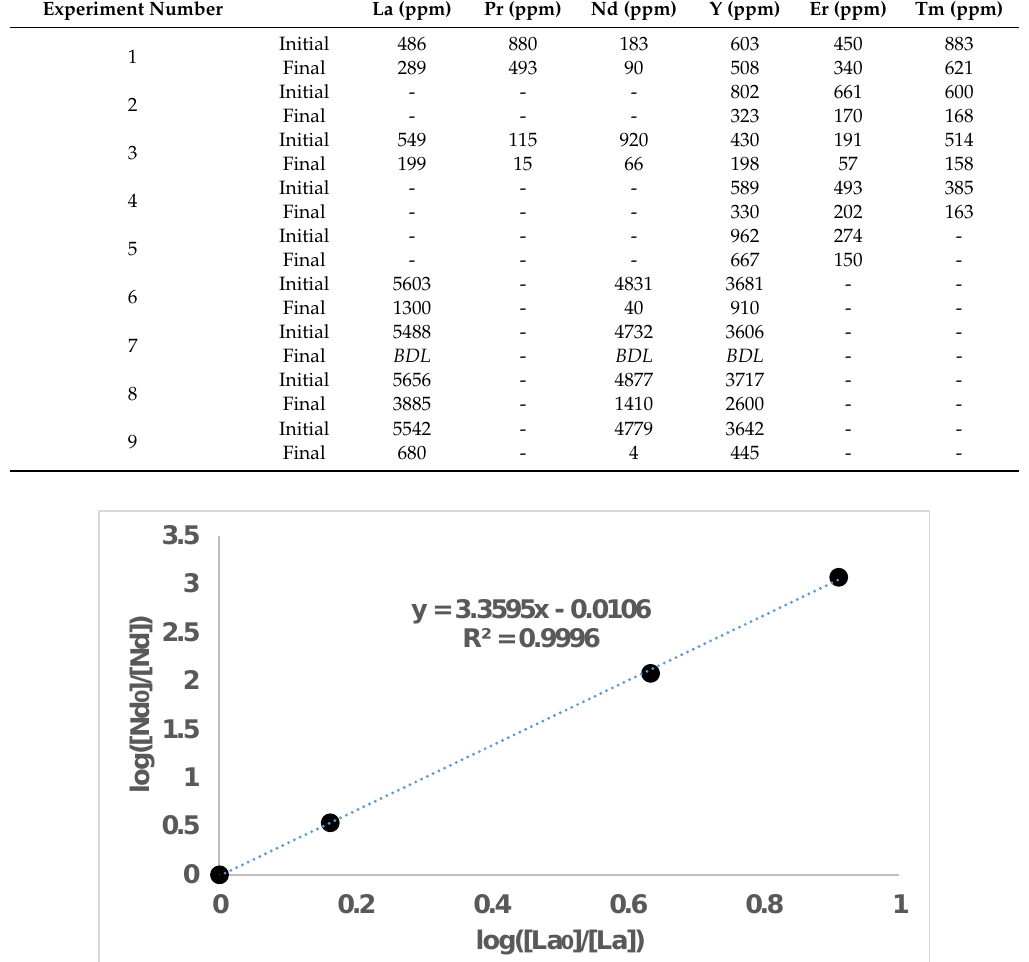
Figure 1. Enrichment of Nd against La: logarithm of the quotient of the starting concentration and final concentration for each rare earth.